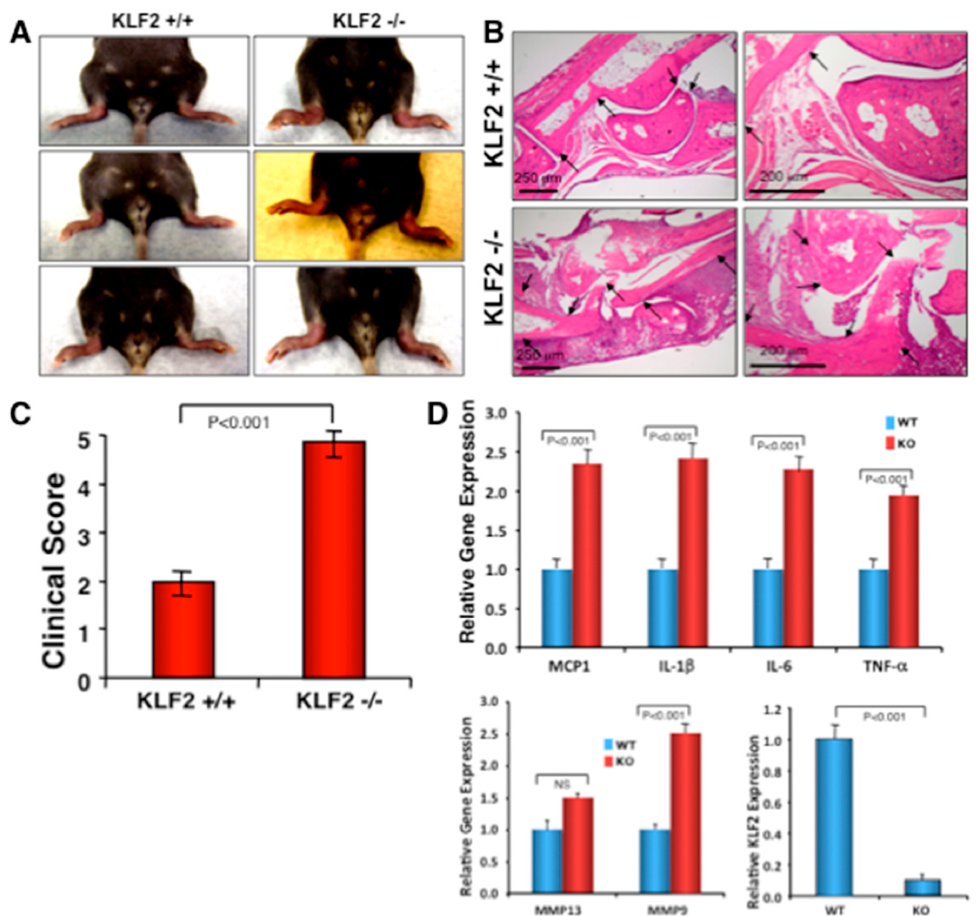
Figure 4. Monocyte-specific conditional KLF2 knock out enhances K/BxN serum-induced arthritic pathogenesis. The effect of K/BxN serum-induced arthritis was assessed in myeloid specific conditional KLF2 knockout mice. ( A ) Representative morphologies of arthritic inflammation in hind limbs. ( B ) Histopathological images of bone and joints after H&E staining. ( C ) Measured